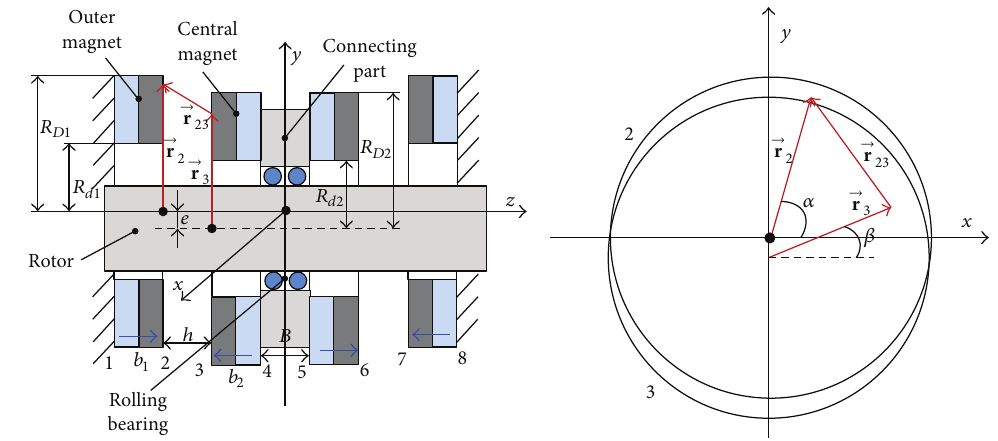
Figure 1: Structure of the magnetic spring with negative